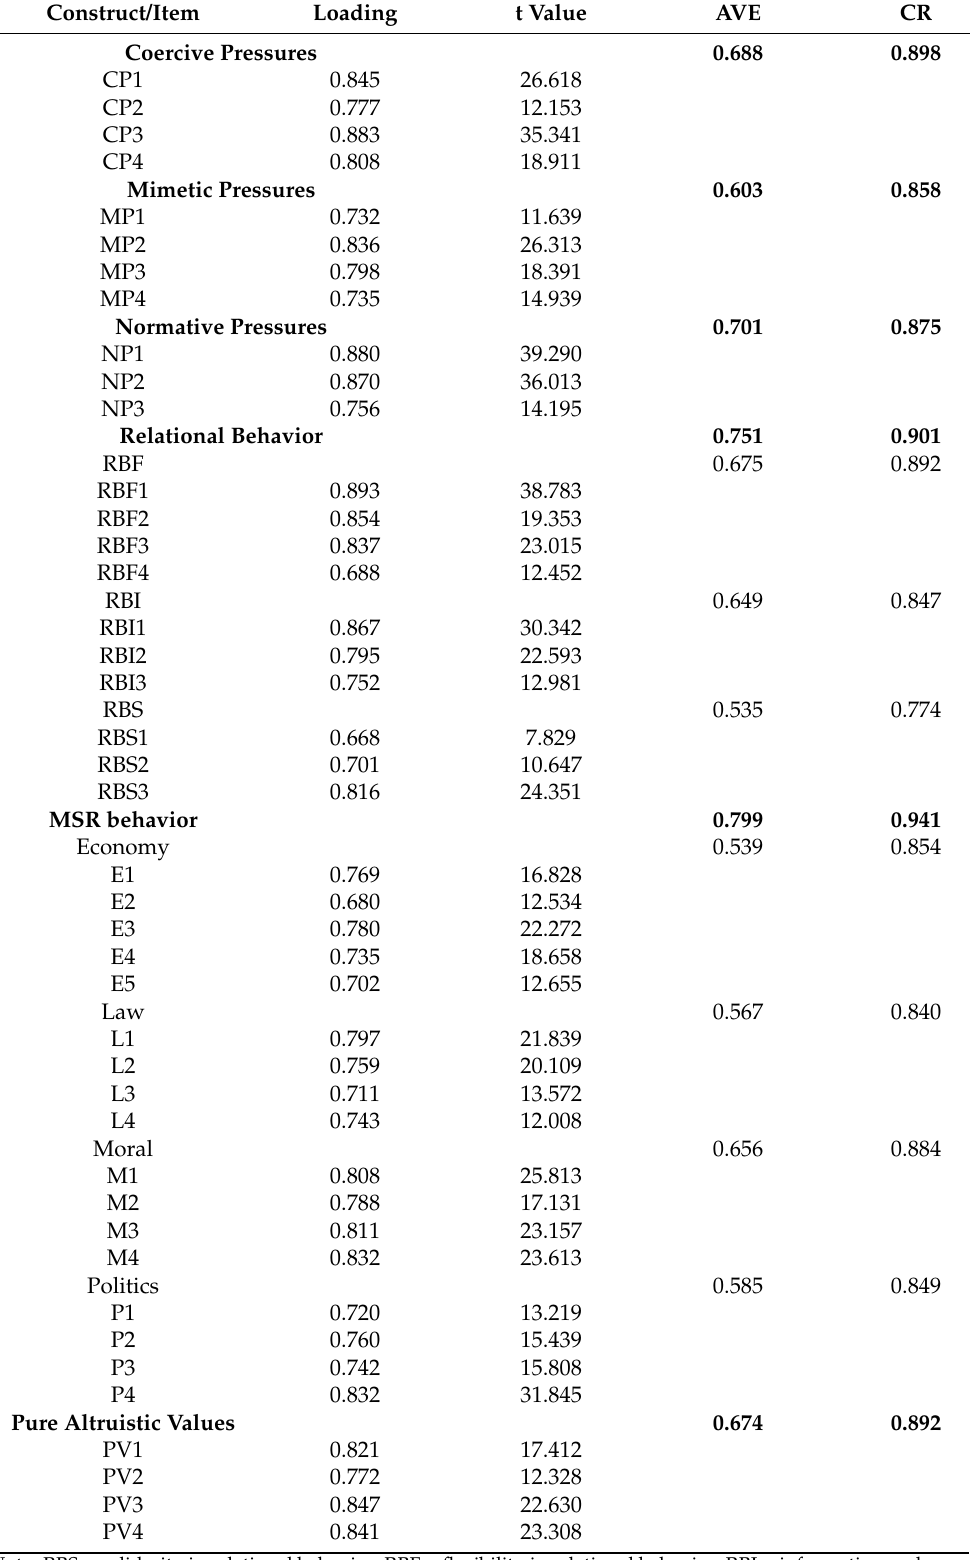
Table 3. Evaluation of Measurement